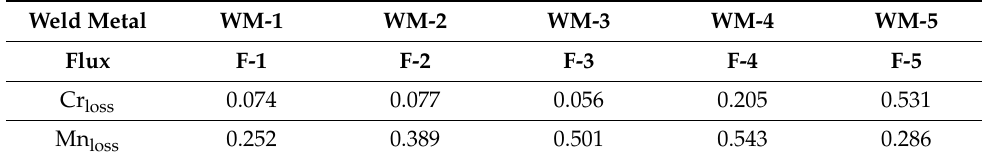
Table A5. The estimated Cr loss and Mn loss values for 100 g WM (g). Weld Metal